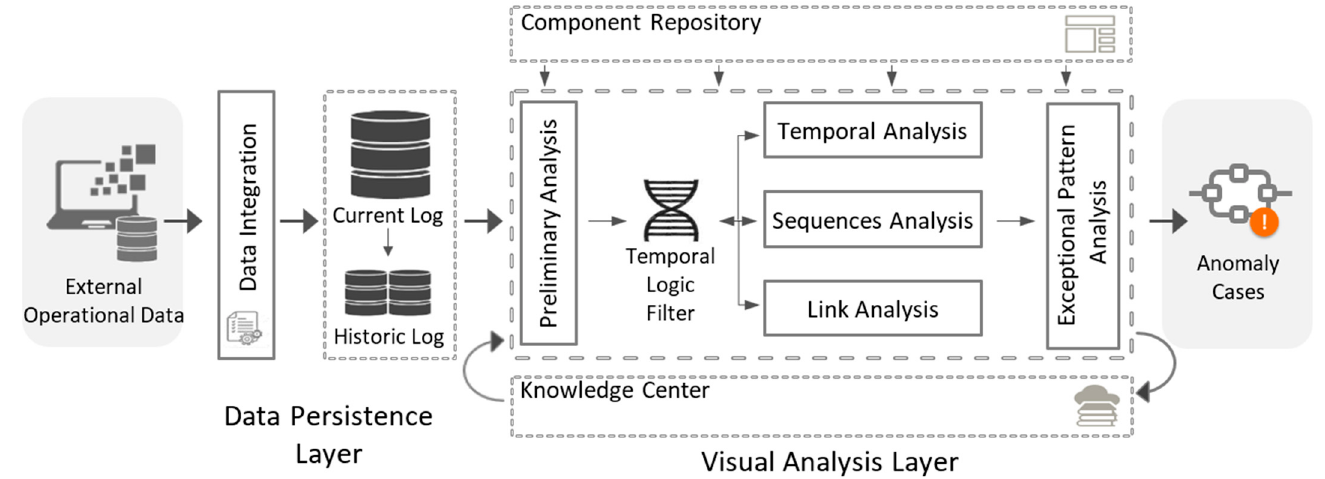
Figure 1. Conceptual schema for fraud audits of business